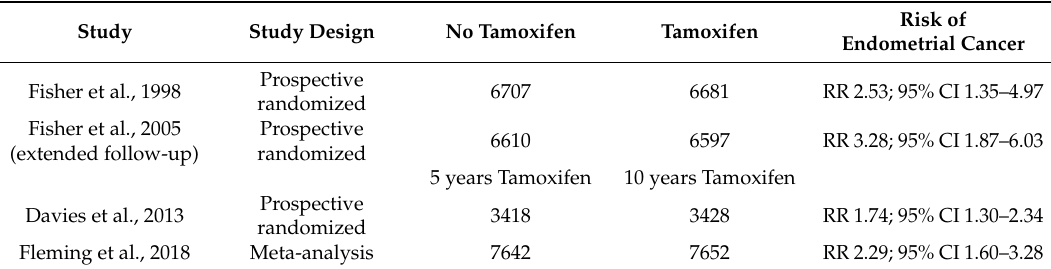
Table 3. Characteristics of the studies included in this review regarding tamoxifen use and endometrial cancer